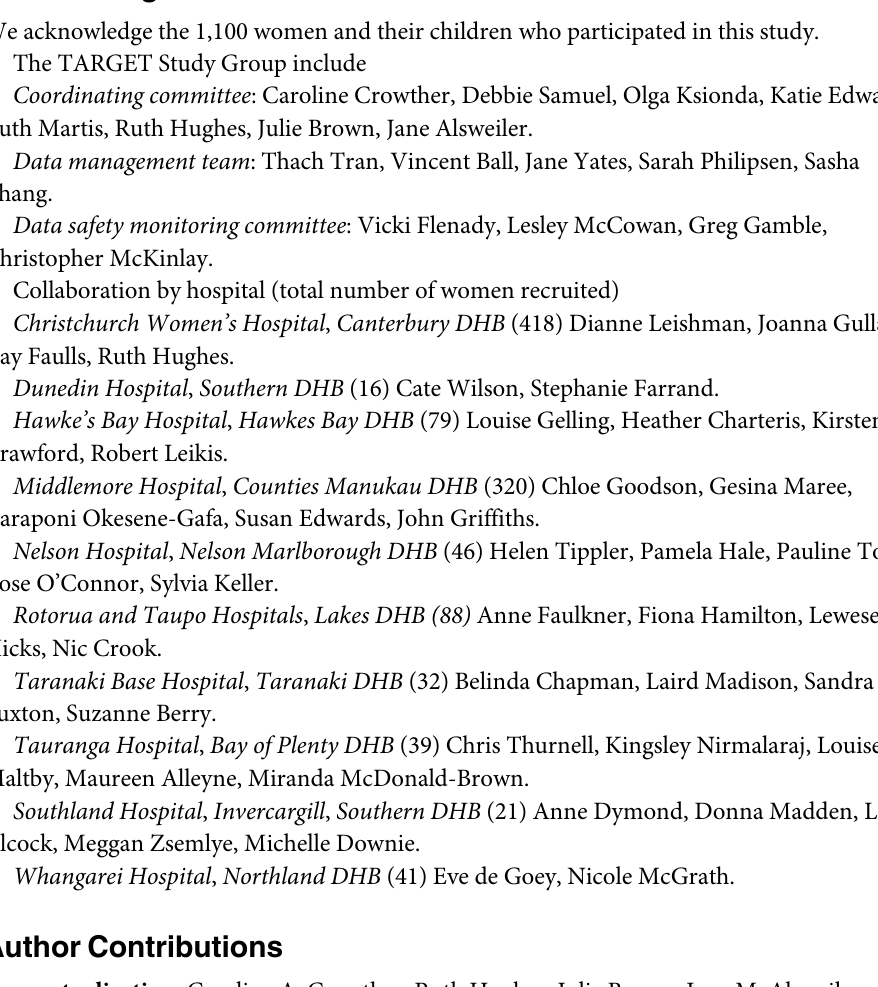
S4 Table. TARGET Study